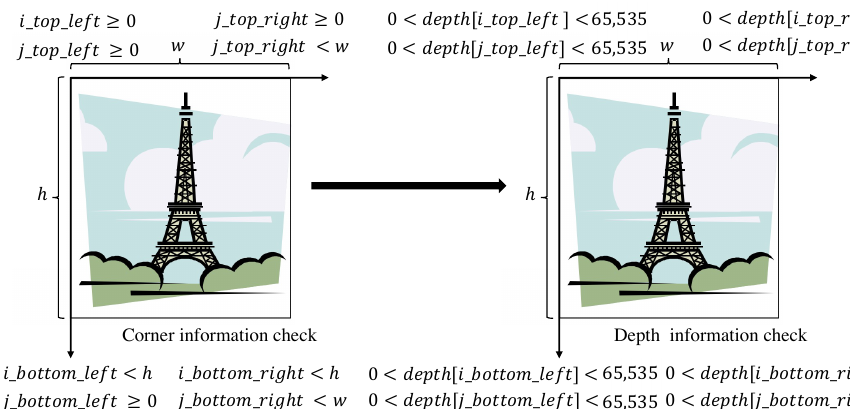
Figure 1. Corner information and depth information pixel judgment of the depth map. Figure 4.3. Corner information and depth information pixel judgment of depth map After obtaining the filtered depth image and its corresponding position grid, we use weight coefficients, which are determined by the upper and lower bounds of the i and